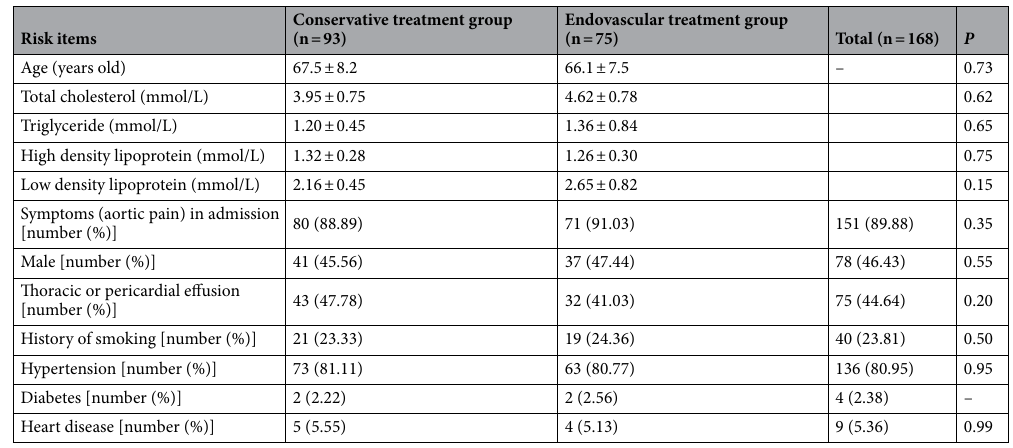
Table 1. Comparison of risk factor of patients treated with two different methods (x ±